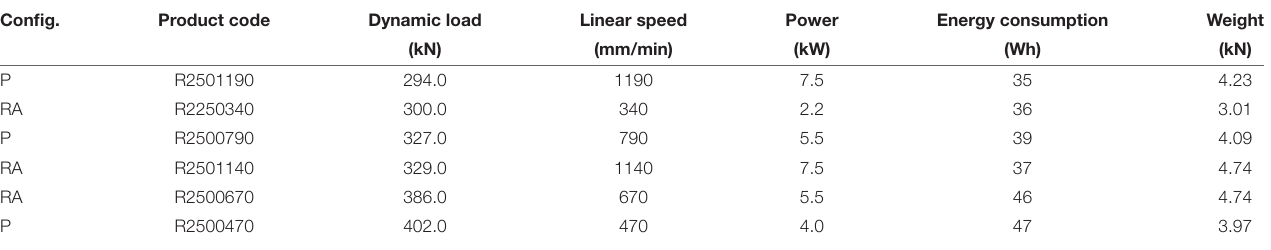
TABLE 7 | Main parameters of Rolaram ® linear actuators. Config.